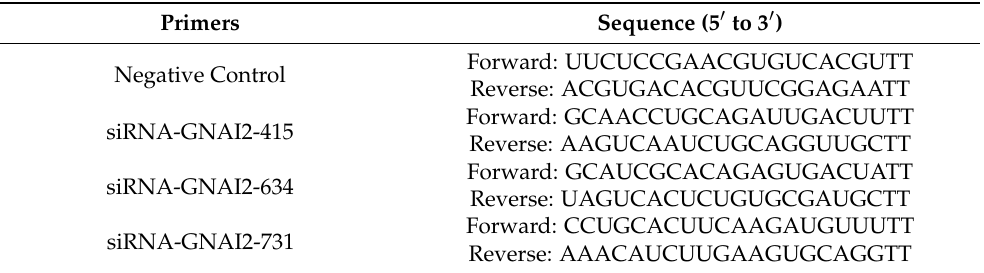
Table 2. Primer sequences of the GNAI2 siRNAs.